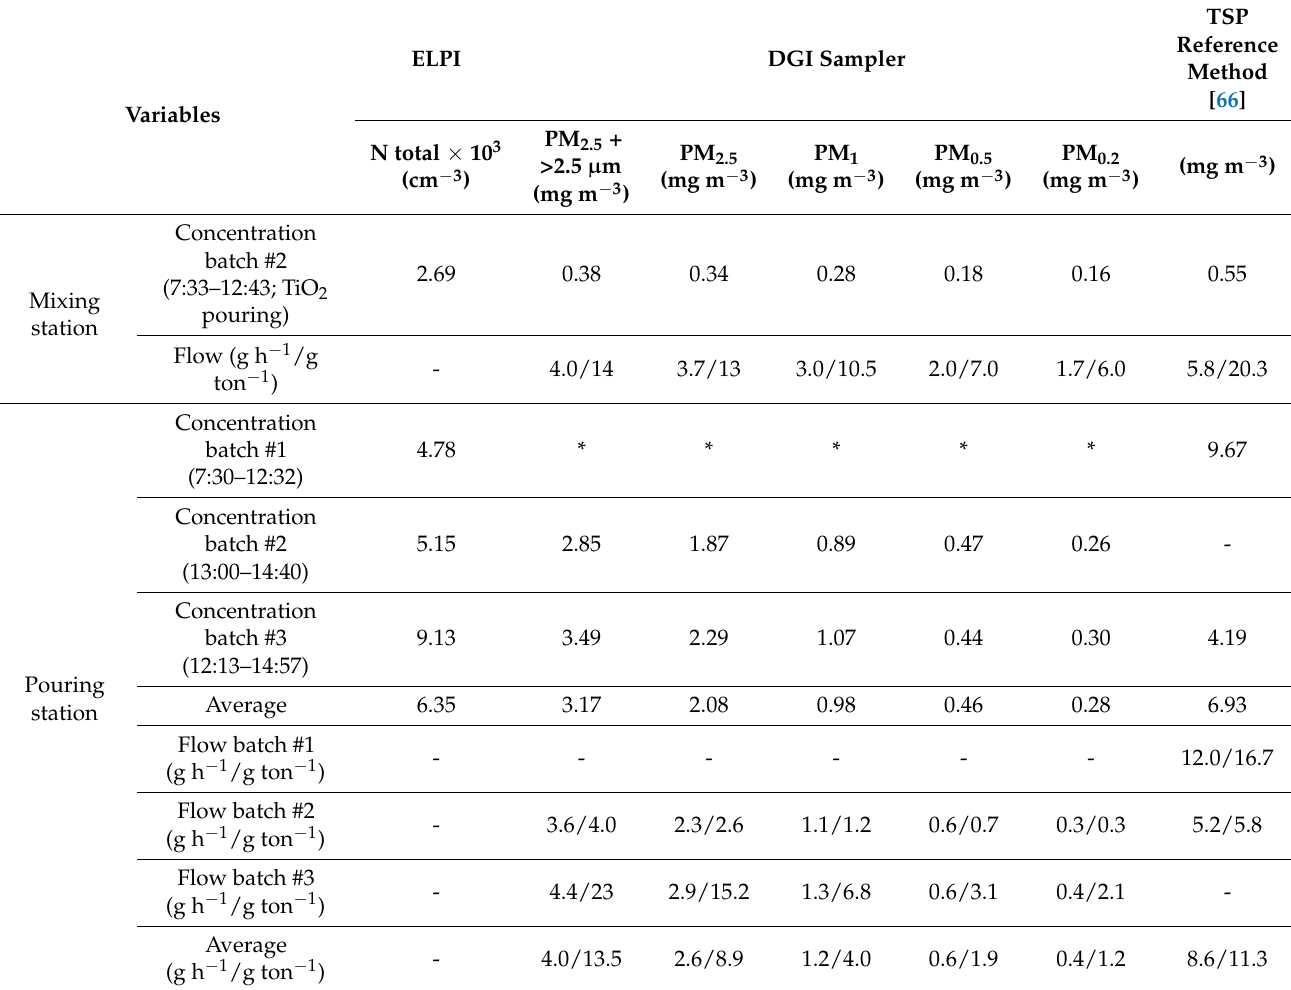
Table 4. Emissions detected at the stack of both mixing and pouring stations in terms of the total particle number, total suspended particles (TSP), and size fraction particle